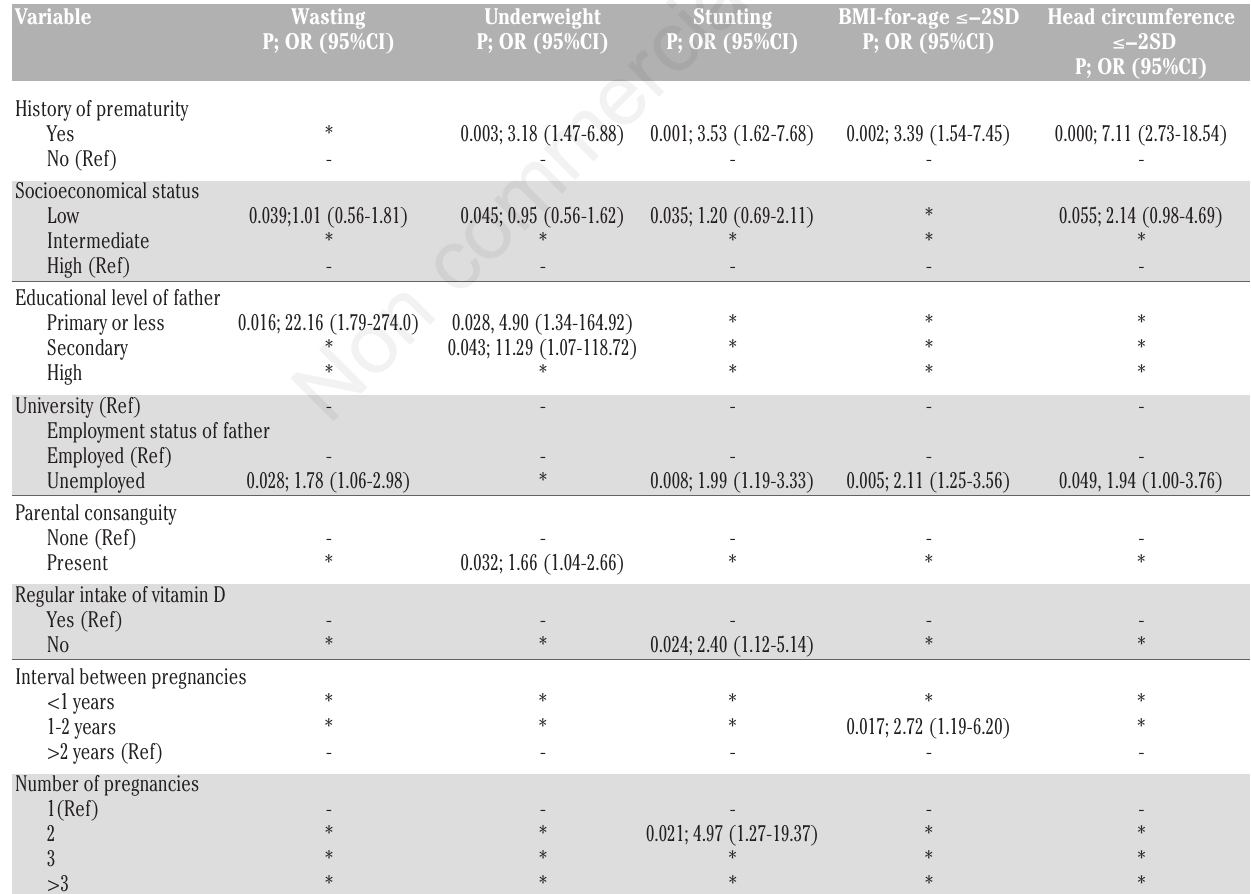
Table 3. Results of the logistic regression analysis of variables, which are significantly related to wasting, underweight, stunting, body mass index and head circumference among 0-5 year old children.